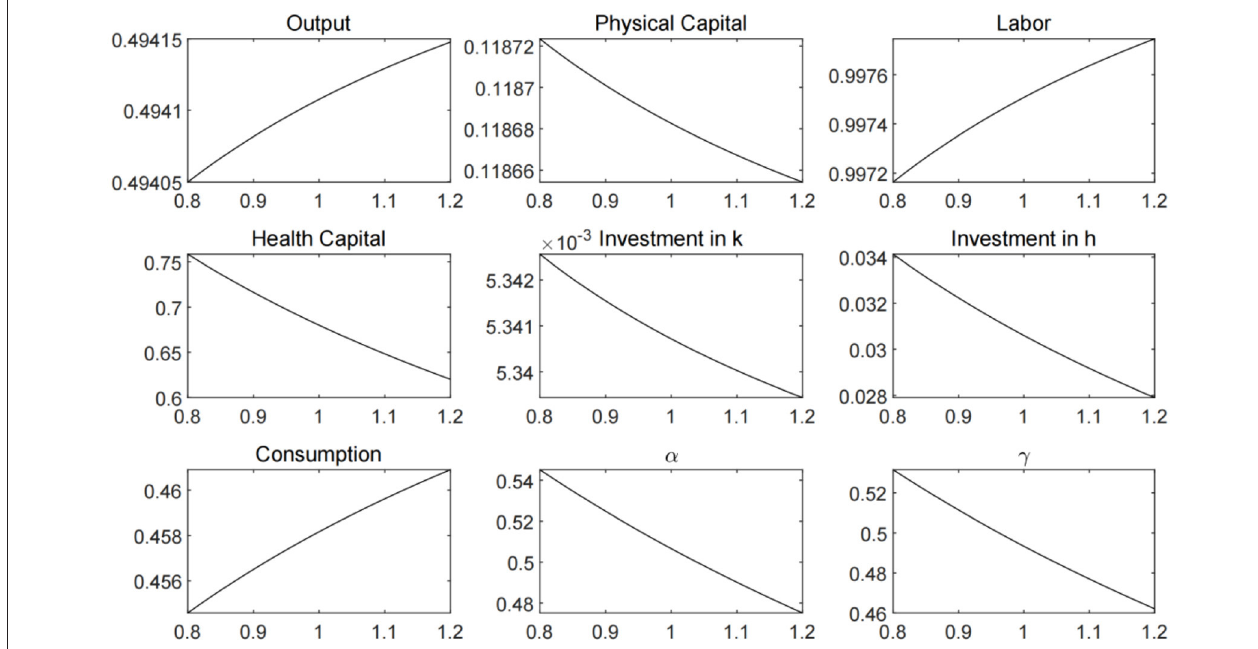
FIGURE 3 | Economic steady states under different ξ values.